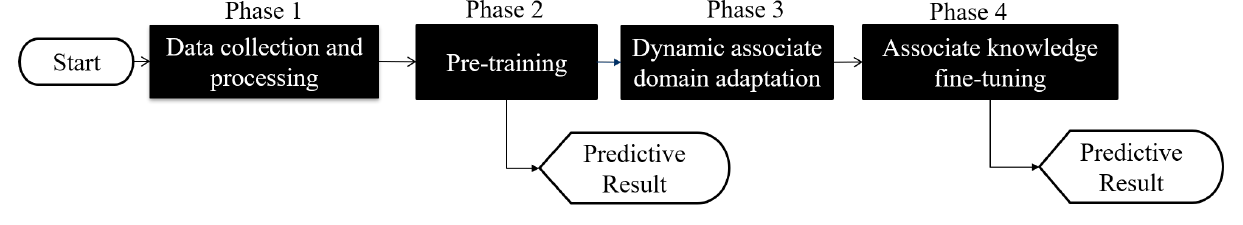
Figure 7. The flow chart of AD-DADA